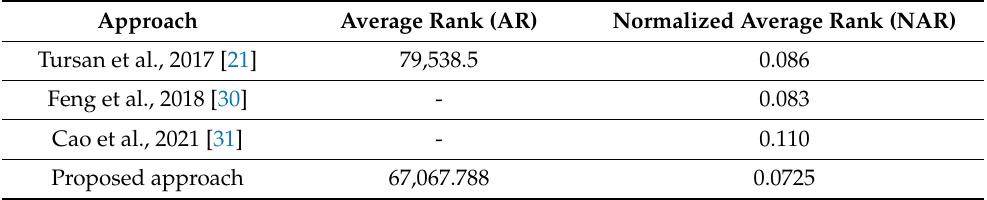
Table 3. Comparison between the proposed approach and sate-of-the-art